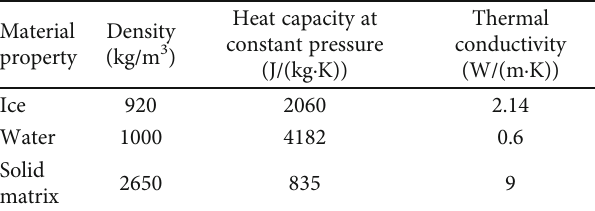
Table 1: Material properties of ice, water, and solid